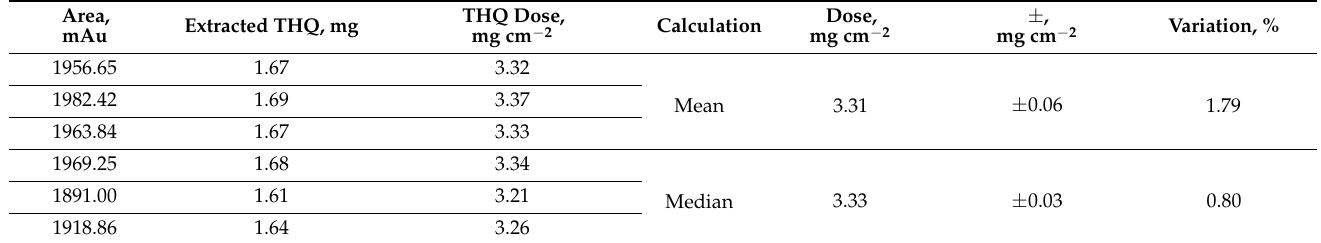
Table 4. Extraction results from thymoquinone dose determination (formulation THQ.010) n = 6. Area,